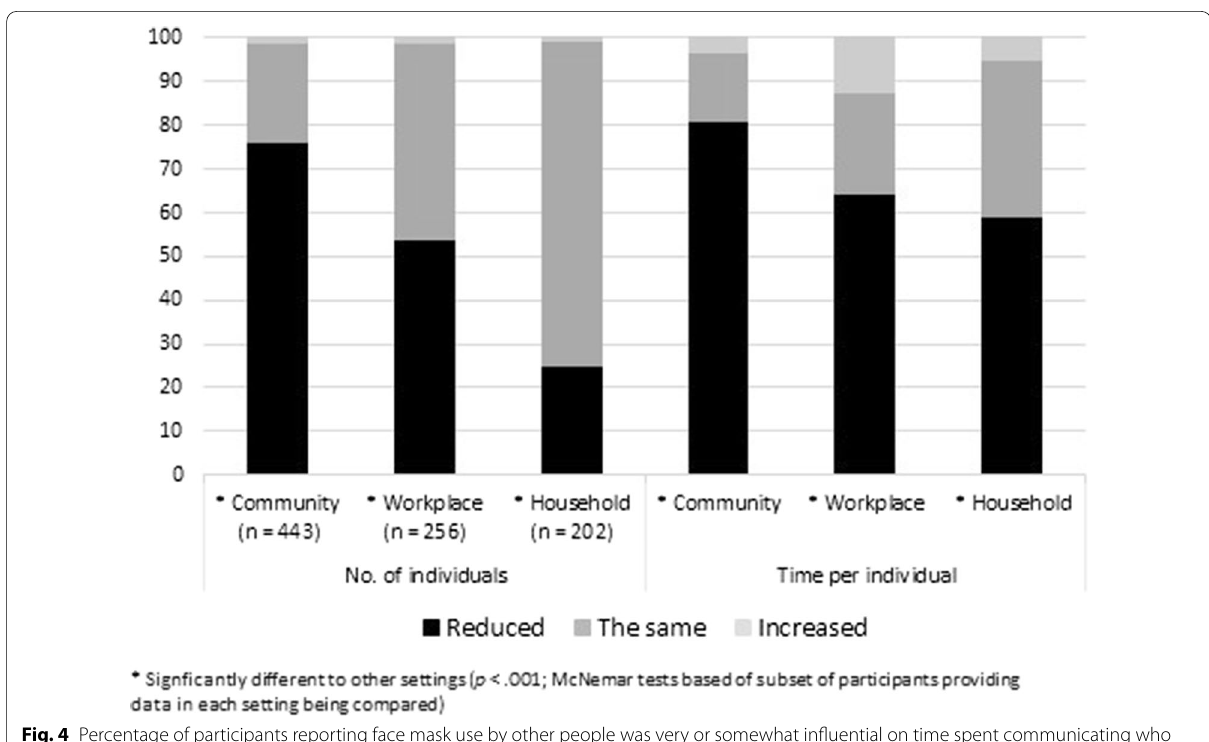
Fig. 4 Percentage of participants reporting face mask use by other people was very or somewhat influential on time spent communicating who reported a worsened, the same, or improved impact on the number of individuals communicated with and the time spent communicating per individual in the community ( n 443), in the workplace ( n 256), and with household members ( n = = =